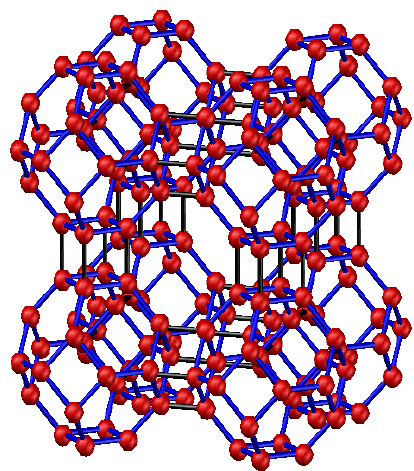
Figure 1. Structure model of 4 Å molecular